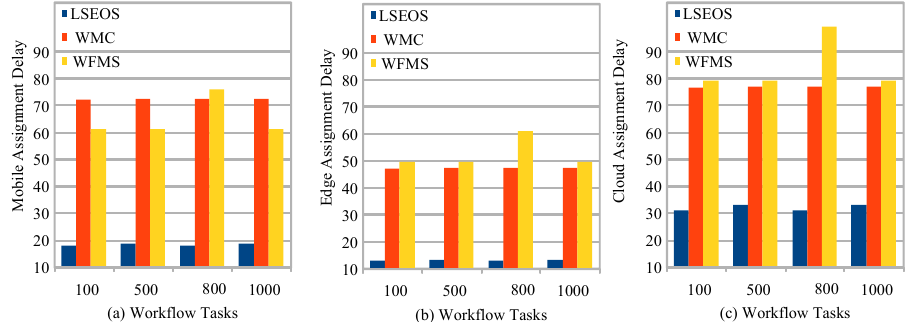
Figure 9. Lightweight secure adaptive offloading and scheduling workflow task